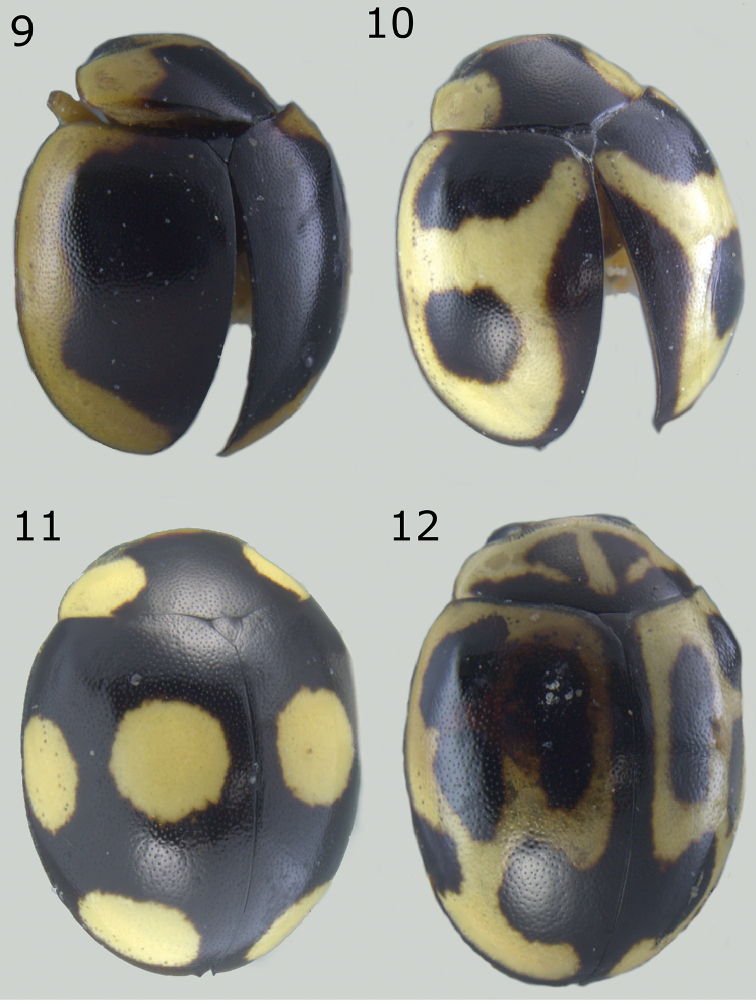
Brachiacantha sp. 9Brachiacantha
guatemalensis comb. nov., male 10Brachiacantha
papiliona sp. nov., female 11Brachiacantha
mimica sp. nov., female 12Brachiacantha
gorhami comb. nov., female.